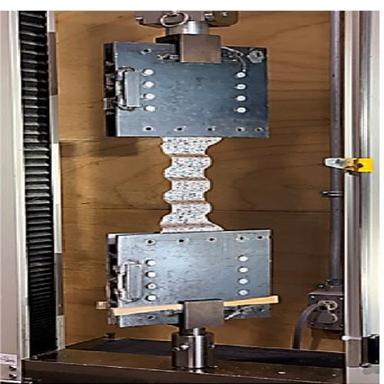
Transverse tensile test on corrugated board with sample dimensions.